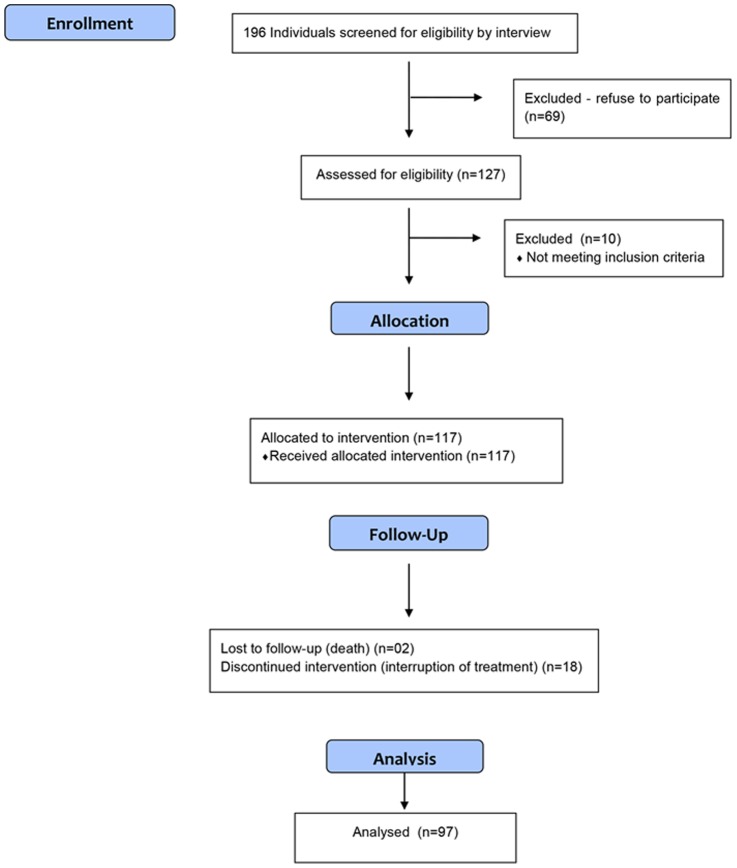
Consort flowchart.